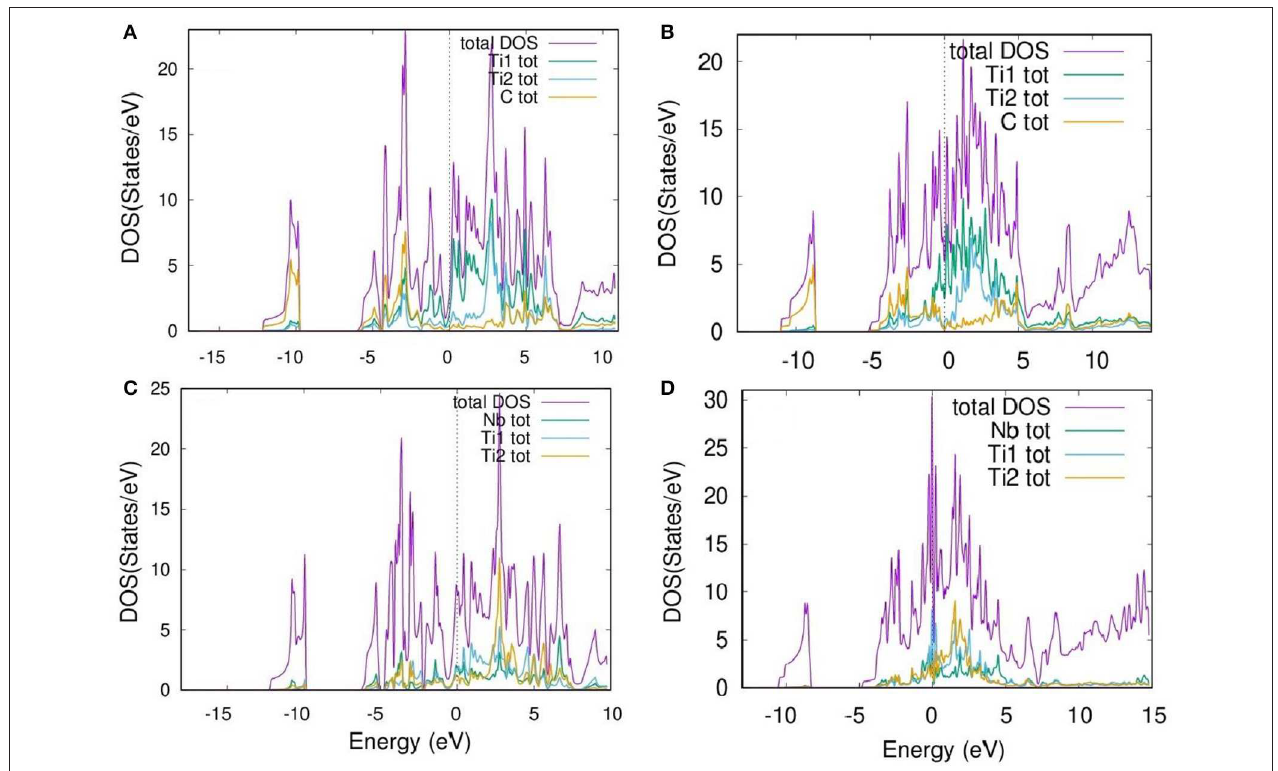
FIGURE 3 | Density of states vs. energy plot for (A) Relaxed Ti 3 C 2 , (B) Experimental Ti 3 C 2 , (C) Relaxed NbTi 2 C 2 , and (D) Experimental NbTi 2 C 2 .